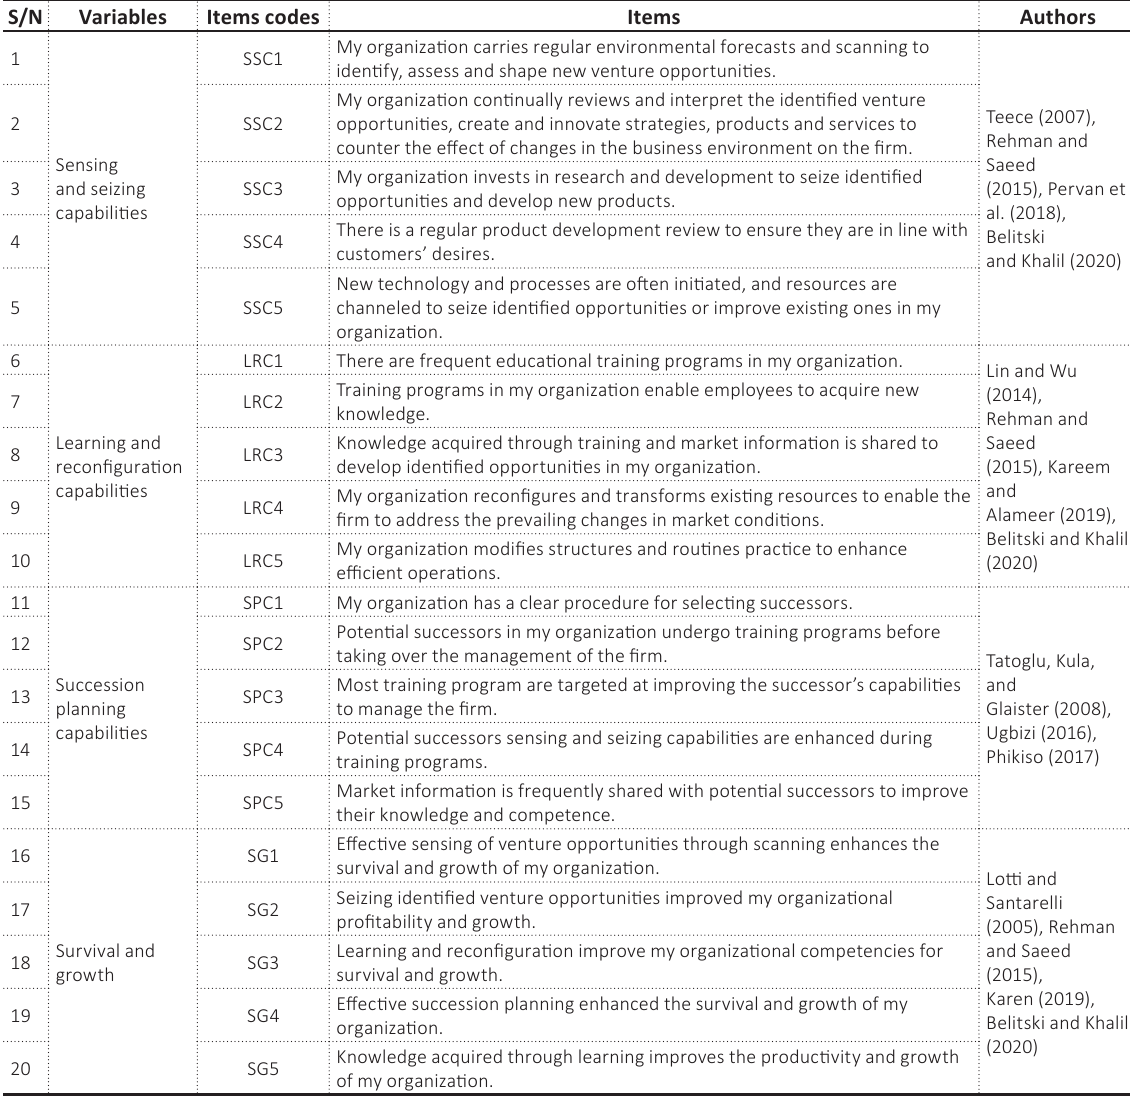
Table 1. Measurement